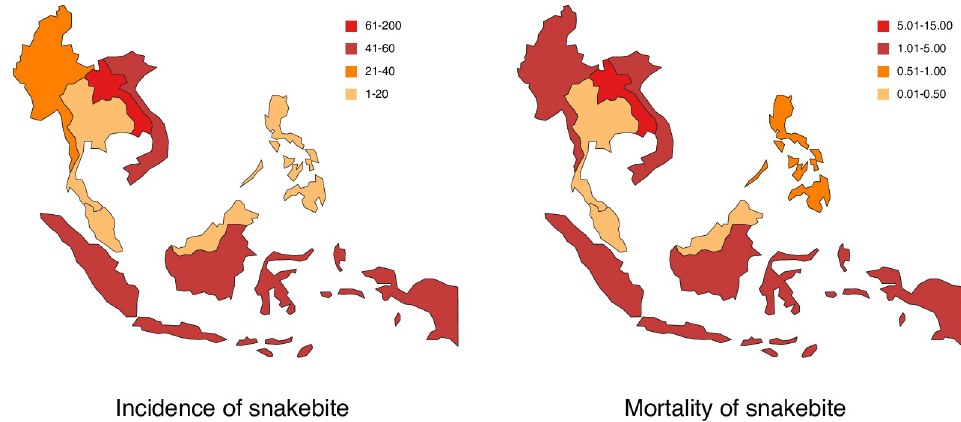
Fig 2. Estimated annual epidemiological burden of snakebite in ASEAN countries. The estimated incidence of snakebite ranged from the lowest in Malaysia (10.68 per 100,000 population) to the highest in Lao PDR (200.00 per 100,000 population). The estimated mortality of snakebite envenoming ranged from the lowest in Thailand (0.006 per 100,000 population) to the highest in Lao PDR (14.04 per 100,000 population). Main sources of information were national statistics and published research for the burden estimation of Malaysia, Thailand, and Myanmar. Published research and anecdotal evidence (local data, and expert opinion) were the main sources of information for the burden estimation of Vietnam, and Lao PDR. Anecdotal evidence was the only source of information for the burden estimation of Indonesia, and Philippines. Made with Natural Earth. Free vector and raster map data @ naturalearthdata.com.